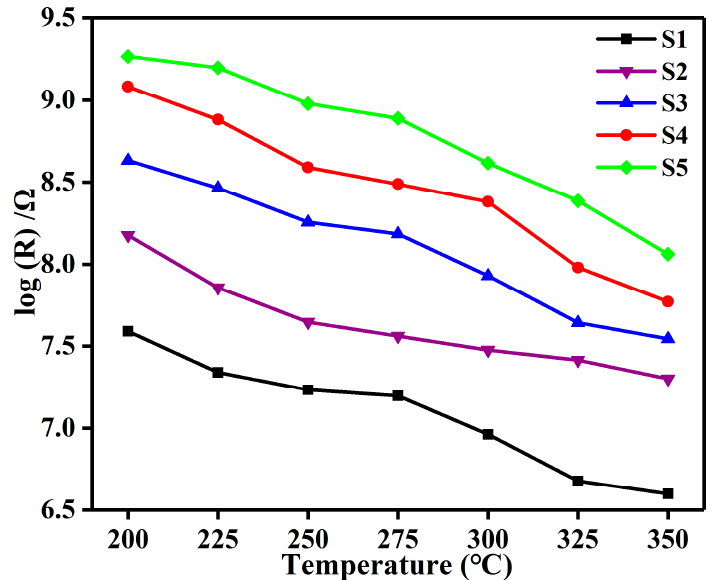
Figure 9. Resistance in air (log R a ) of S1–S5 in the temperature range of 200–350 °C.